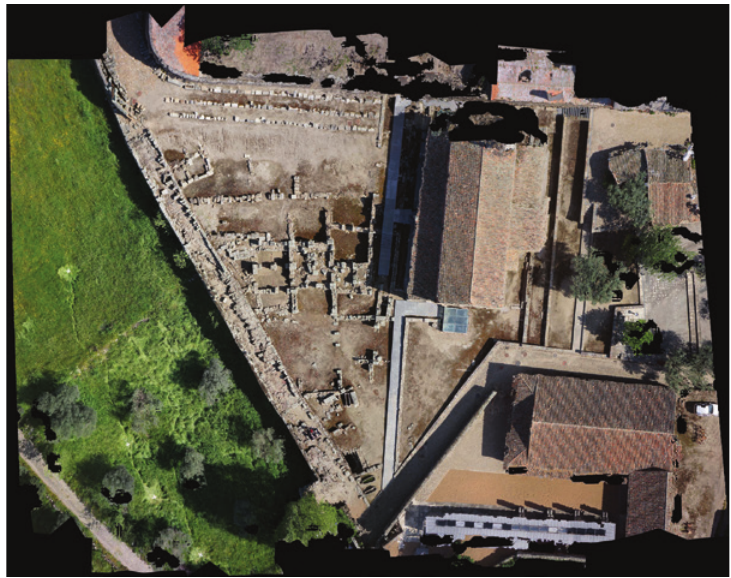
Aerial orthophoto of the late antique Episcopal complex of Idanha- a-Velha, Portugal. (Image credit: ULP.PILAEMA